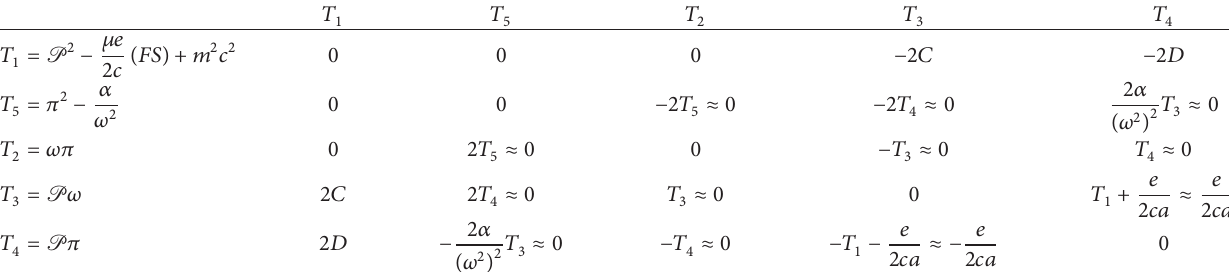
Table 2: Algebra of